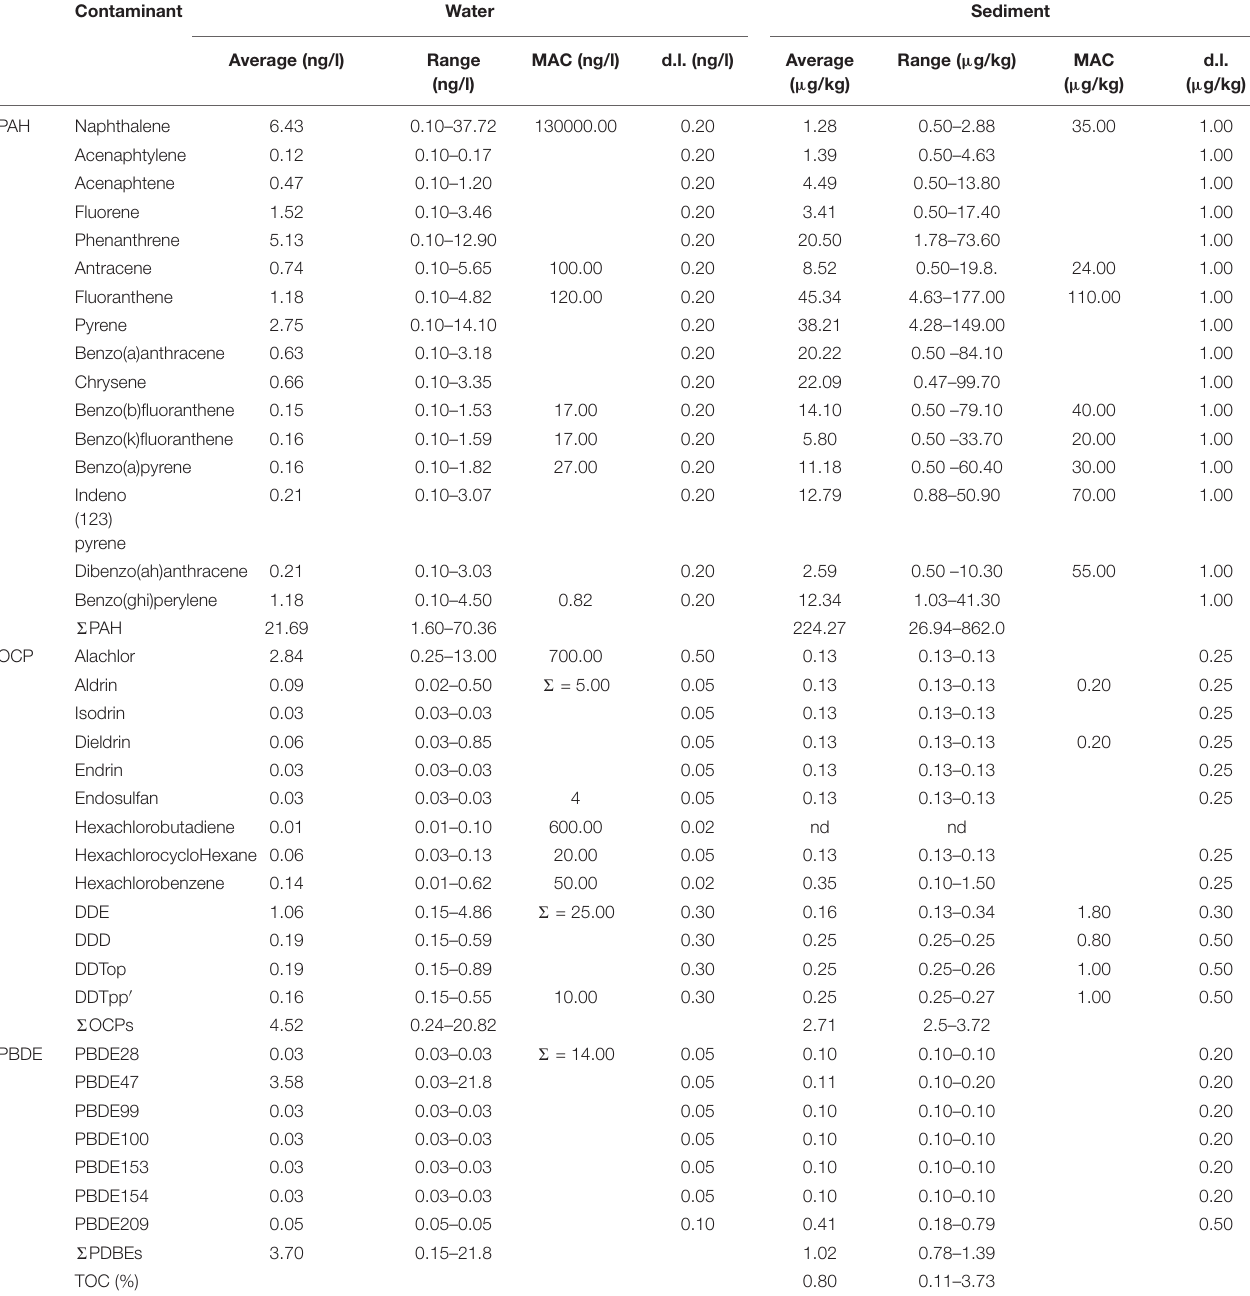
TABLE 2 | Range and mean contaminant concentrations in seawater and